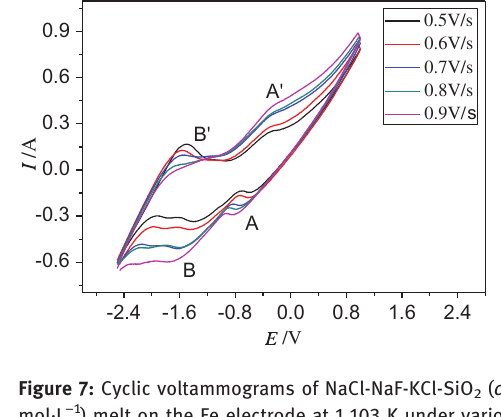
Figure 7: Cyclic voltammograms of NaCl-NaF-KCl-SiO 2 ( c SiO2 = 0.177 mol·L − 1 ) melt on the Fe electrode at 1,103 K under various scan